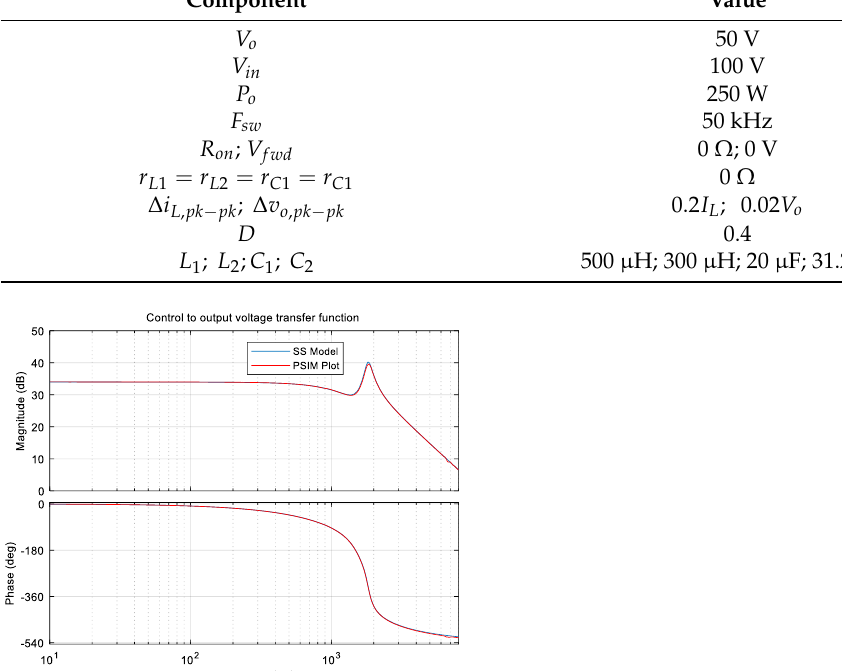
Figure 16. Control − to − output voltage transfer function for a buck converter with an input filter.